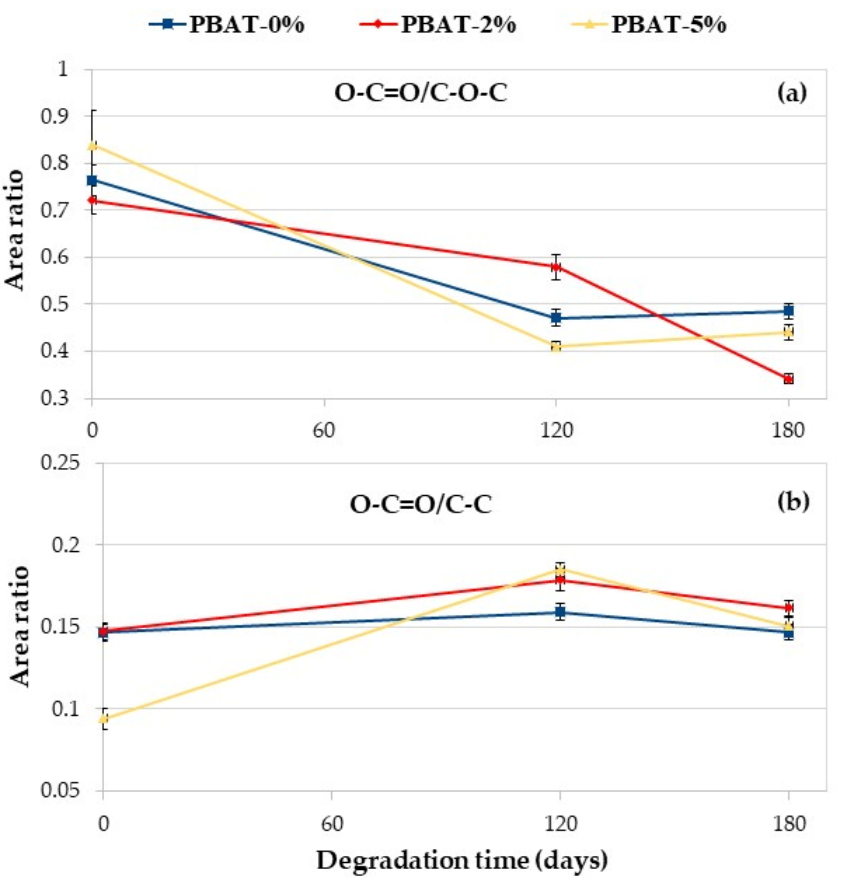
Figure 7. XPS C 1s area ratio vs. degradation time: ( a ) O–C=O/C–O–C; ( b ) O–C=O/C–C.